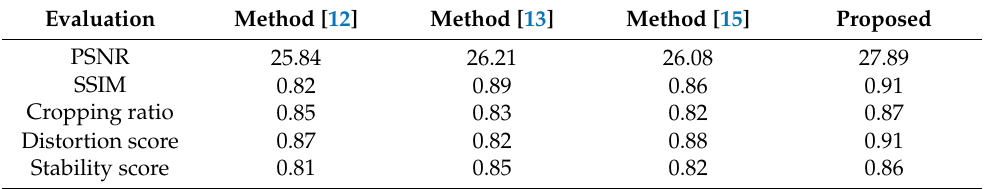
Table 3. Video stabilization effect comparison of video 3.